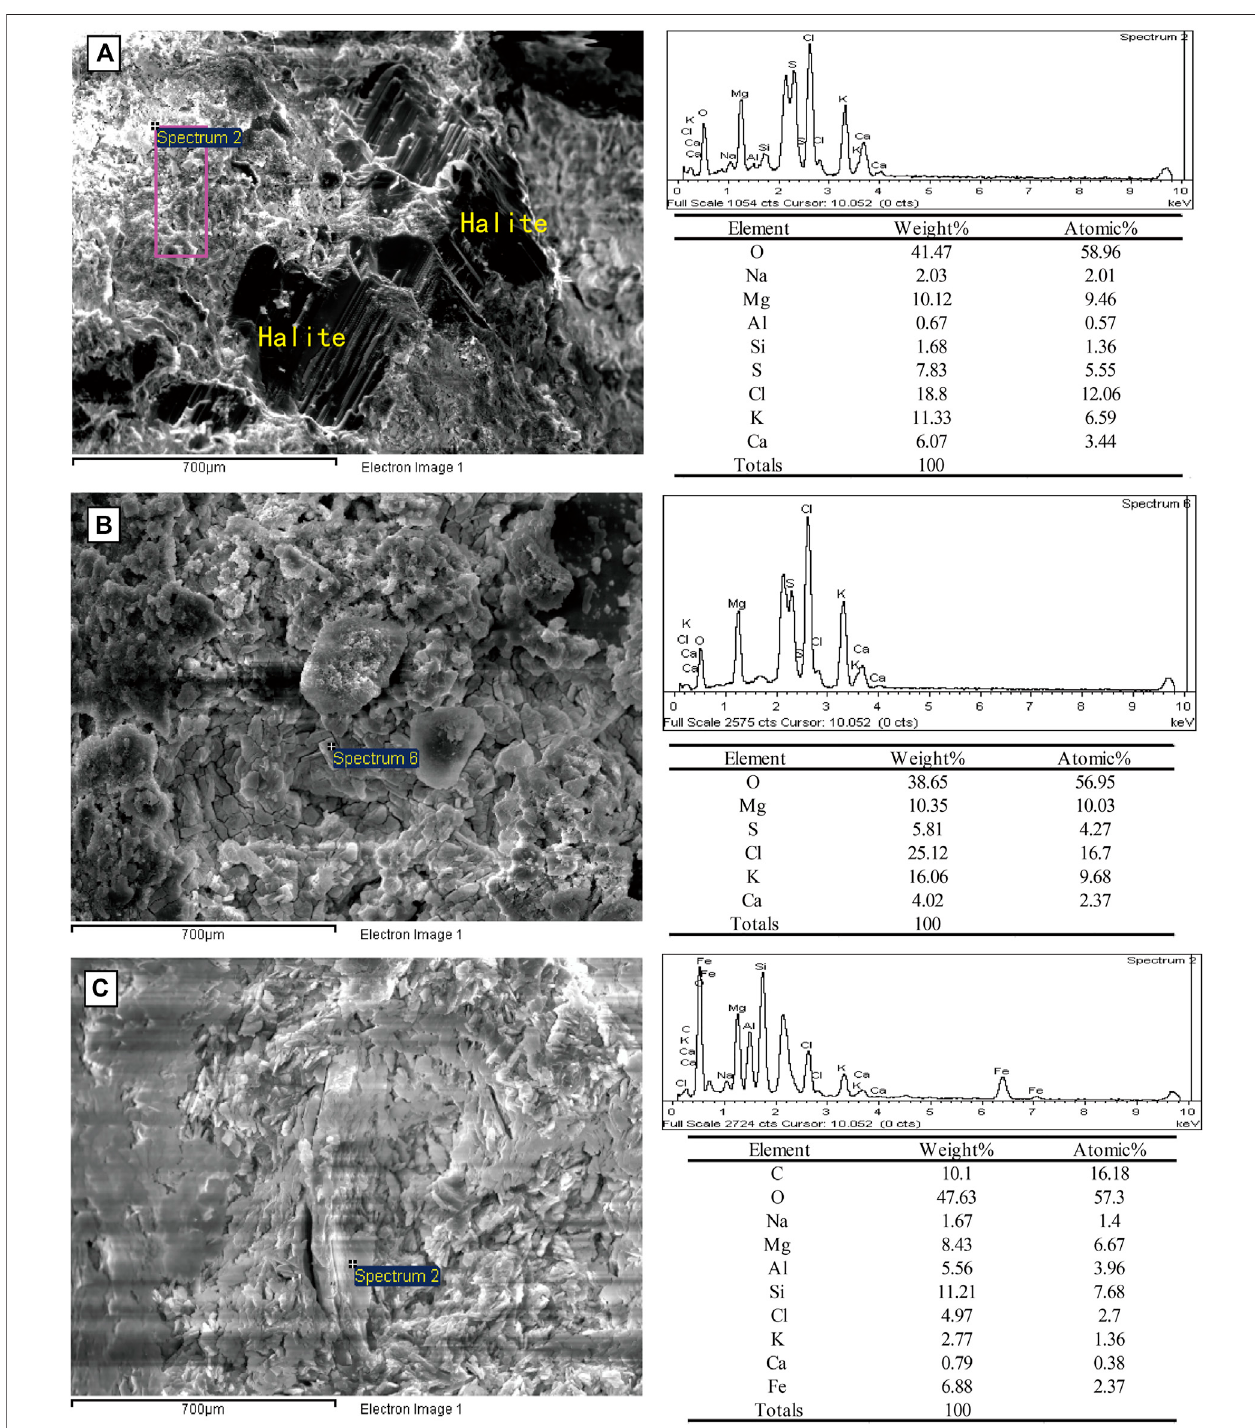
FIGURE5| ImagesofmineralsfromSEM(left)and relativelytheresultsofmineralspectrums fromEDS(right).Inimage (A) (fromsampleBD-10),thescanningarea purple rectangle is an aggregation of some minerals. In image (B) (from sample BD-13), the scanning point is a polyhalite piece. In image (C) (from sample BD-14), on a larger scale (10 μ m), it shows a more complicated component.